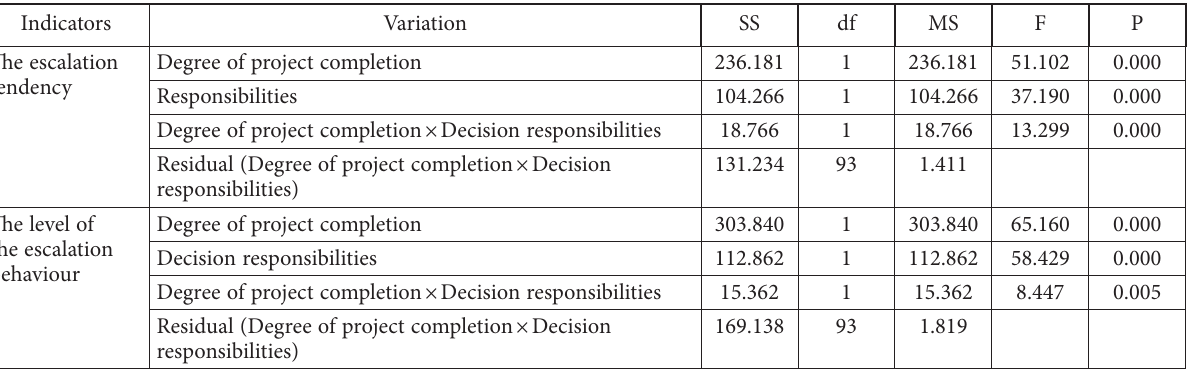
Table 3. Two-way ANOVA of within-subject design of EOC by investors